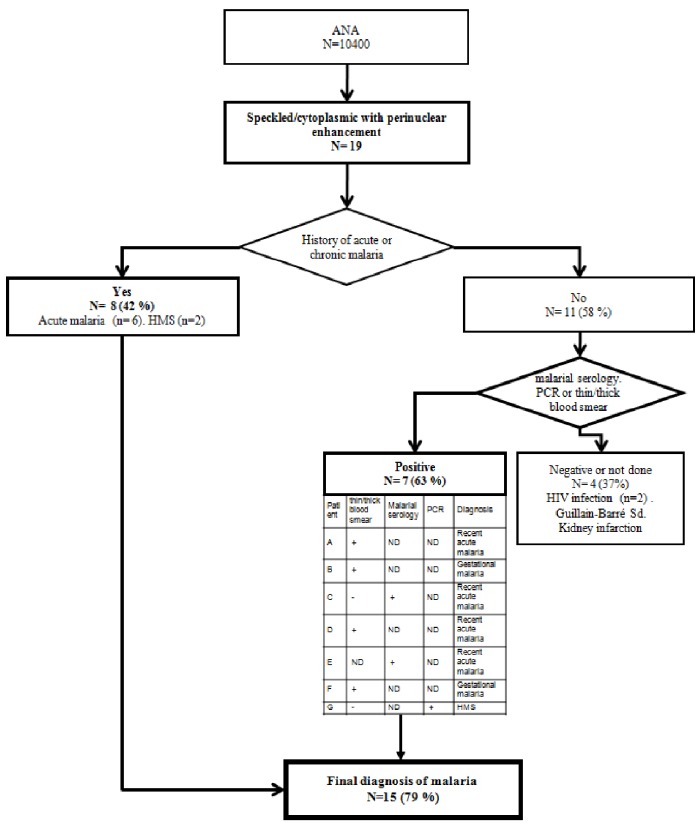
Nuclear speckled and cytoplasmic diffuse with perinuclear enhancement pattern is diagnostic for smoldering malaria.Occurrence or past history of malaria in patients with the distinct nucleo-cytoplasmic pattern was prospectively studied. The pattern was observed in 19 independent sera out of 10 400 ANA tests performed over a 12 month-period. For each patient, the occurrence of malaria was first searched in the medical clinical record file. If history of malaria was absent, serology, PCR or thin/thick blood smear were performed. Diagnosis for each case is indicated. (ND = not done).